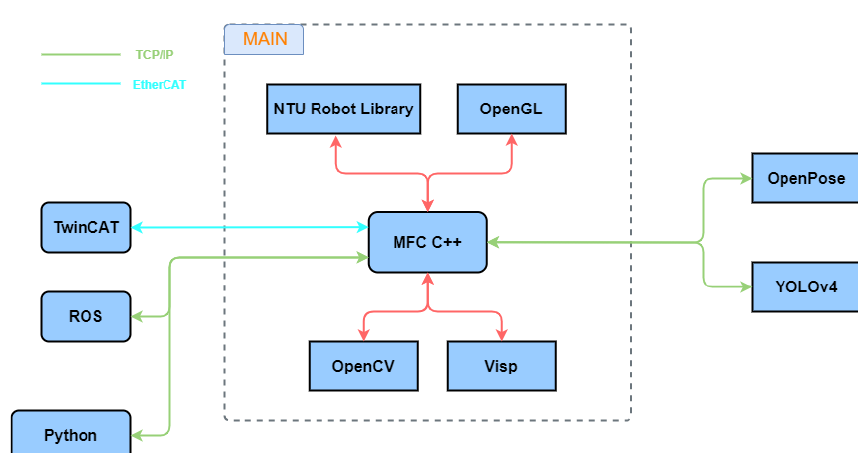
Figure 13. Soft architecture.